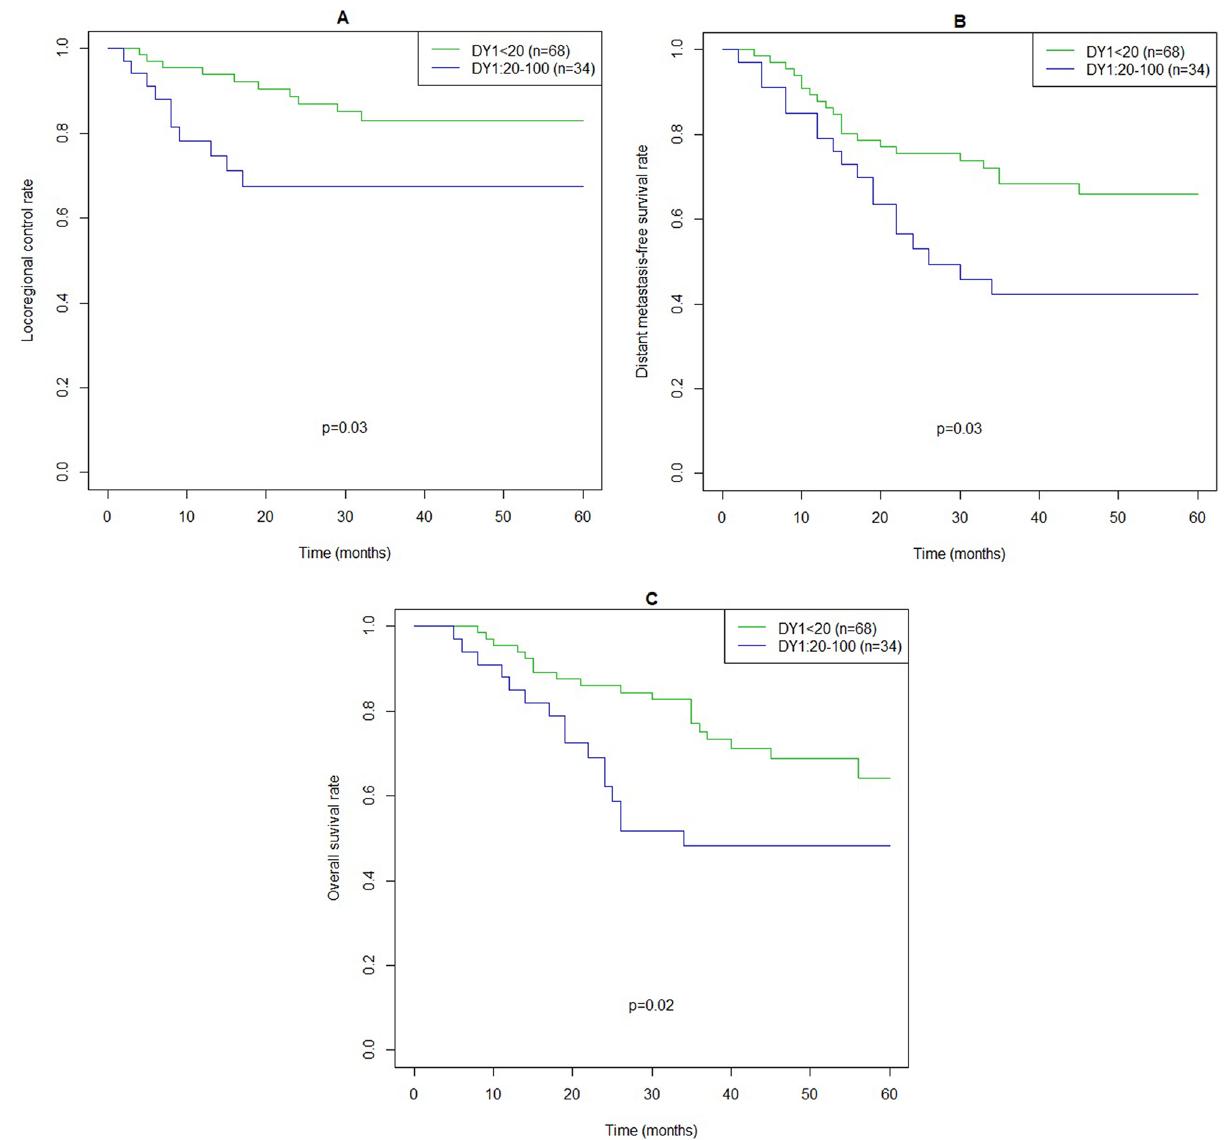
Figure 1. Locoregional control rate ( A ), distant metastasis-free survival rate ( B ) and overall survival rate ( C ) based on diarrhea score at 1 month after treatment. DY1: score for diarrhea at 1 month after